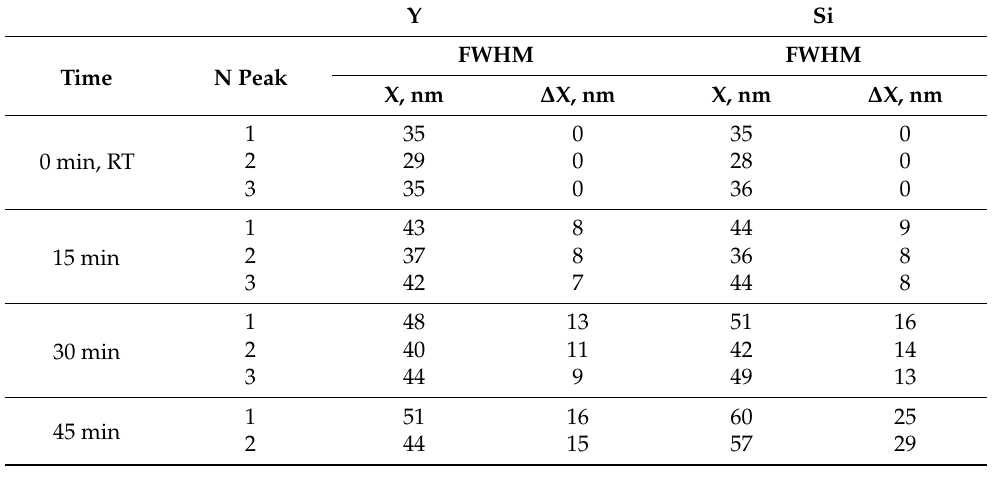
Table 1. The change in the depth penetration, ∆ X, of silicon and yttrium in the layers at the initial stage and after annealing at a temperature of 700 ◦ C for Ti 0.2 Al 0.55 Cr 0.2 Si 0.03 Y 0.02 N/Ti 0.25 Al 0.65 Cr 0.1. .